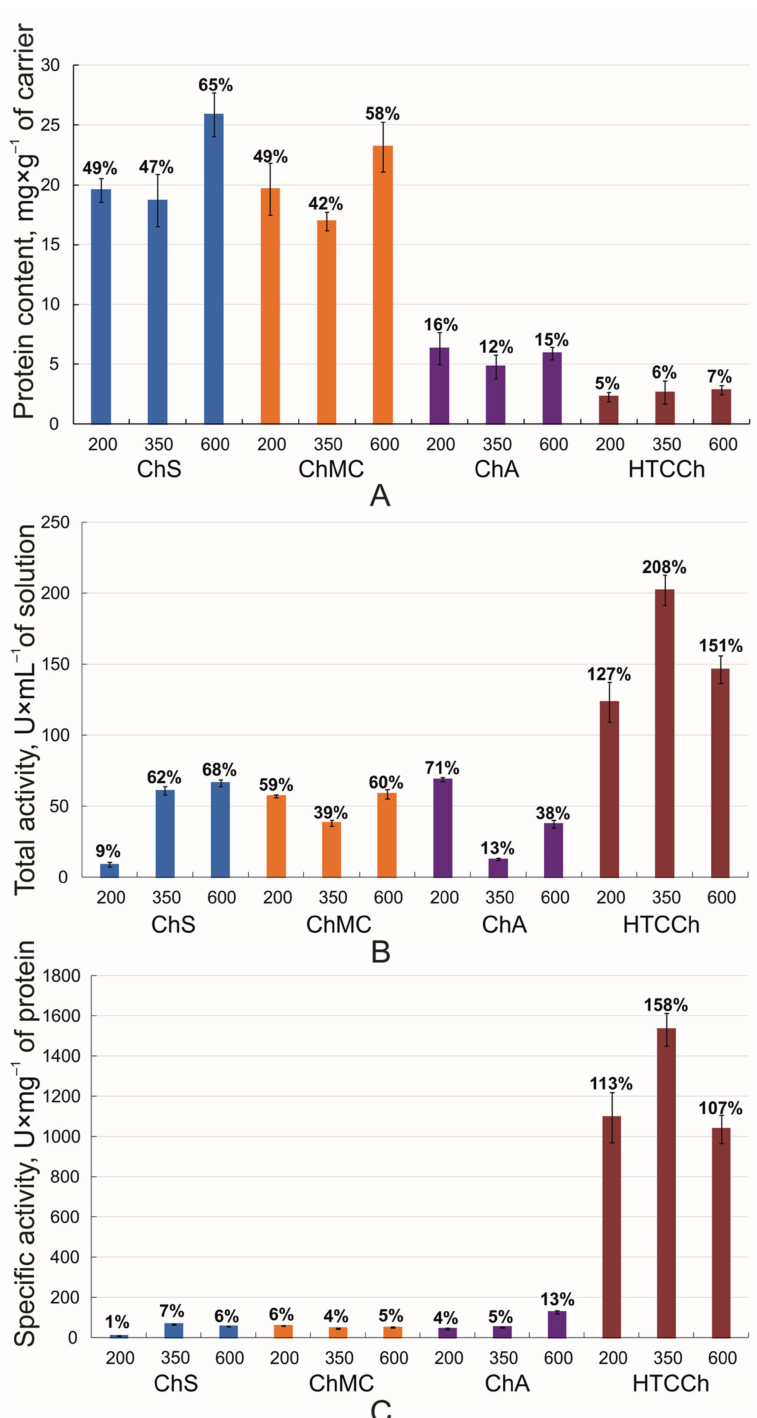
Figure 1. Characteristics of immobilized bromelain: ( A ) Protein content (mg · g − 1 of carrier) in enzyme complexes with ChS, ChMC, ChA, and HTCCh; ( B ) total activity (U · mL − 1 of solution) of enzyme complexes with ChS, ChMC, ChA, and HTCCh; ( C ) specific activity (U · mg − 1 of protein) of enzyme complexes with ChS, ChMC, ChA, and HTCCh. The efficiency of complexation for bromelain expressed as a percentage of the adsorbed enzyme compared with its amount in solution ( A ), the total activity of immobilized enzyme compared with soluble enzyme ( B ), and the specific activity of the immobilized enzyme compared with the dissolved enzyme ( C ) are indicated above the bars. All experiments were performed eight times, and the results represent mean ± confidence